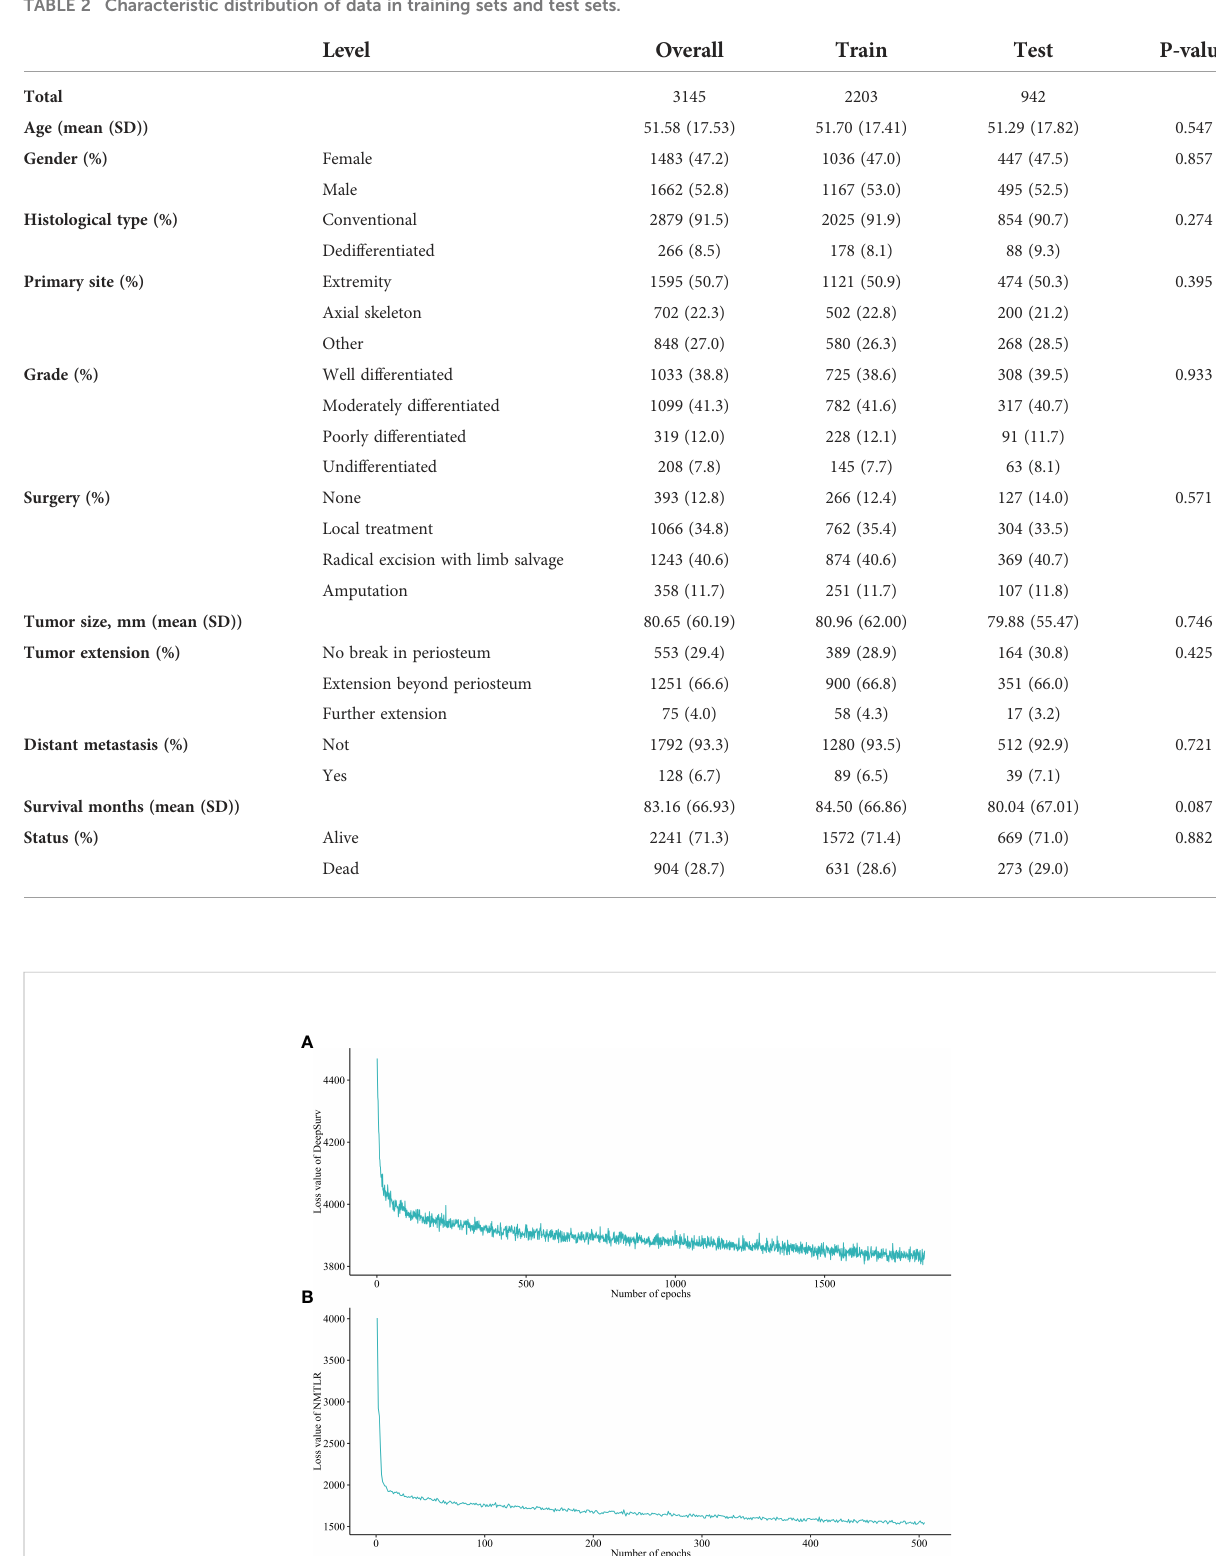
TABLE 2 Characteristic distribution of data in training sets and test sets.